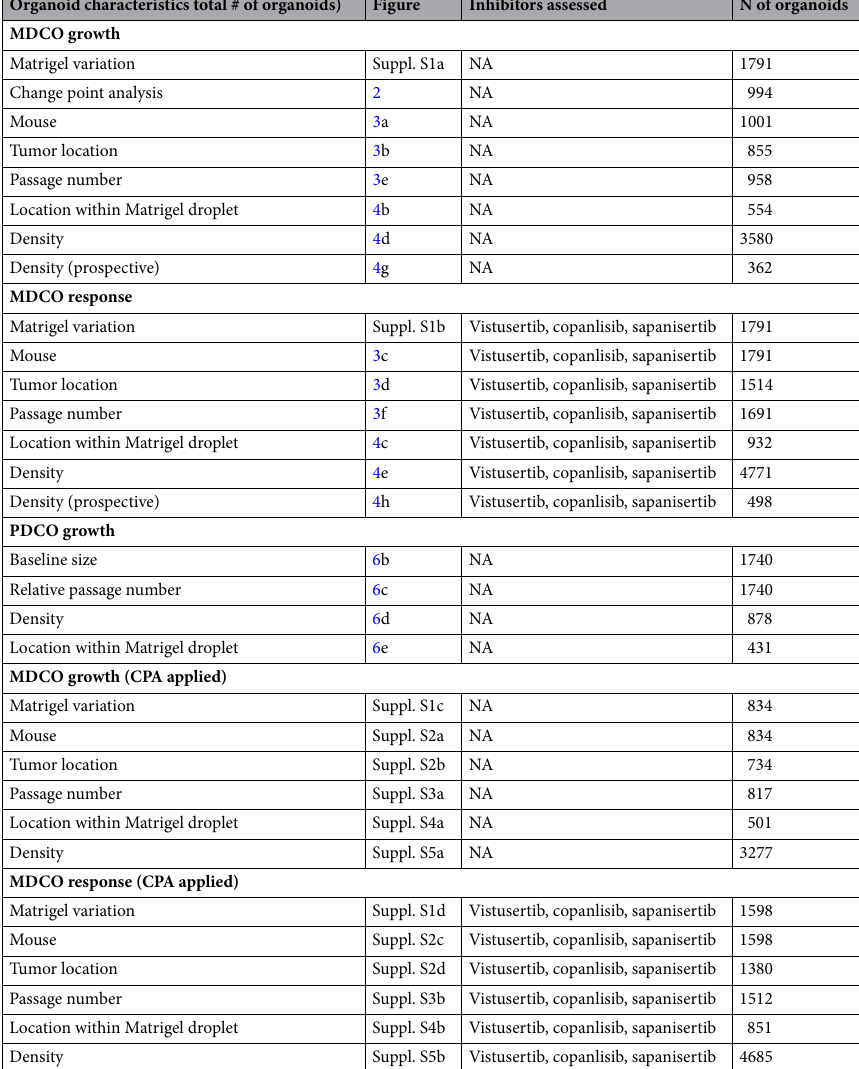
Table 1. Number of individual organoids used in the growth and response organoid characteristic analyses. The number (N) of organoids used in each organoid characteristic analysis is listed, along with the corresponding figure number. For the response analyses, all PI3K pathway inhibitors used are